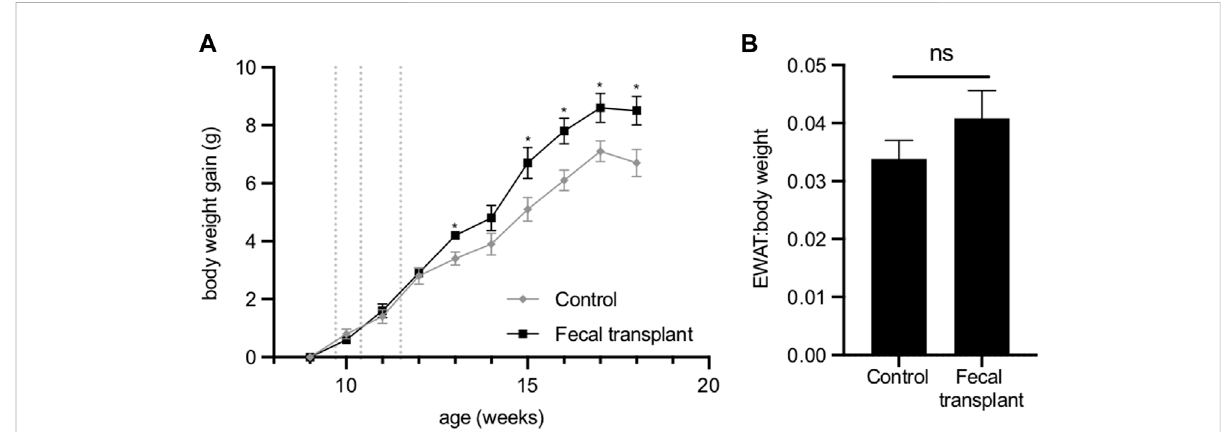
FIGURE 5 Effect of fecal transplantation of wild-type mice with Fmo5 − / − gut bacteria. (A) Body weight gain. Dotted lines indicate the days of dosing of fecal material. * p < 0.05. (B) EWAT:body weight ratio of mice at 18 weeks of age. Control ( n = 5) and fecal-transplanted mice ( n =